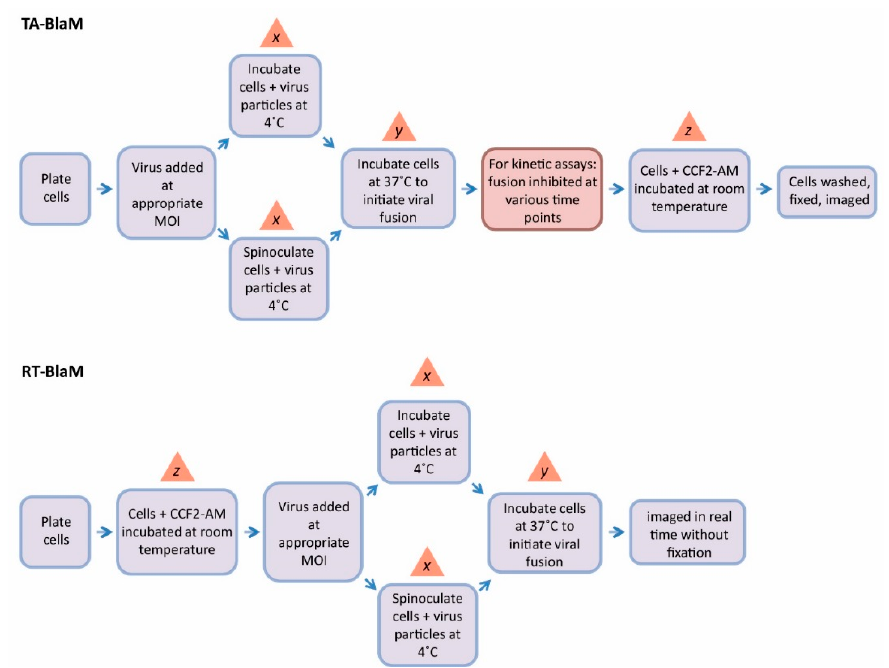
Figure 4. Methodology pipelines for the TA-BlaM and RT-BlaM assays. Virus particles are allowed to fuse before the addition of CCF2-AM in the TA-BlaM assay, and cells are typically fixed before analysis. The red box in the TA-BlaM flow diagram applies to fusion kinetic assays and is omitted under fusion endpoint assay conditions. In a RT-BlaM assay, target cells are loaded with CCF2-AM before being exposed to virus, meaning fusion can be monitored in live cells. The timing used for several steps ( x,y and z ) vary and are discussed in more detail in Section 4 of the main text. MOI = multiplicity of infection.